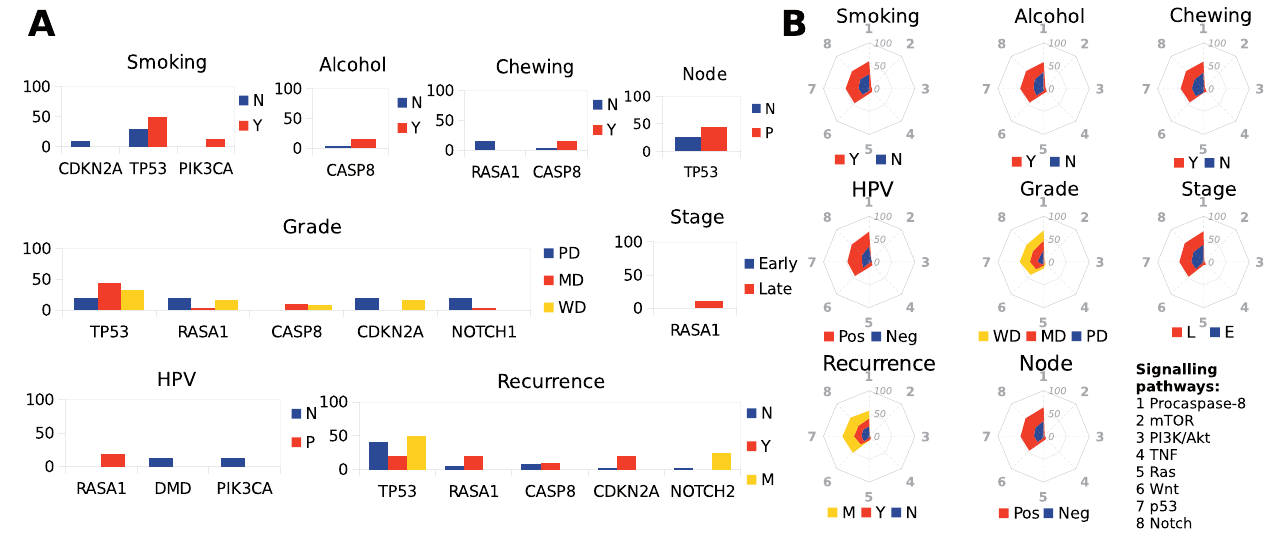
Figure 2. Relationship between genes harboring somatic variants with clinical-, epidemiological parameters and signaling pathways. A . Histograms showing relationship between genes with significant somatic variants and various clinical and epidemiological parameters. For genes solely mutated in one of the clinical or epidemiological categories, or those mutated at a >= 5% frequency between two categories. B . Stack net charts of relative patient fraction (%) for each of the eight cancer-associated signaling pathways and their relationship with various clinical and epidemiological